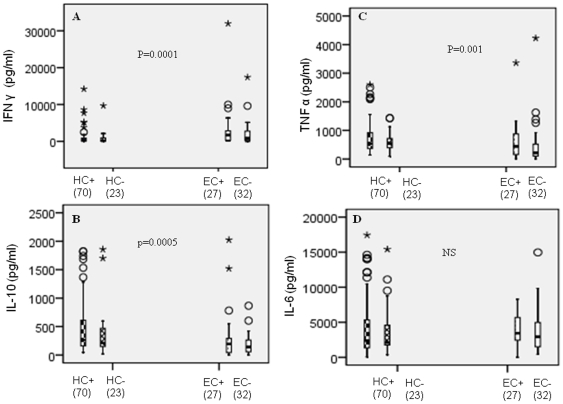
Comparison of CF induced cytokine responses in MTB exposed HC and unexposed EC.Cytokine secretion was assessed in supernatants of stimulated whole blood cultures. CF [5 µg/ml] induced IFNγ secretion was assessed at day 5 and CF induced TNF α, IL-10 and IL-6 secretion was assessed at day 2 post- stimulation. Results are expressed after deducting background secretion in the absence of stimulation. Results are given as box plots representing 25th, 50th and 75th percentiles (logn pg/ml). The number of donors in each group is given in brackets. Significant differences between the HC and EC groups for different cytokines (ANOVA; Kruskal-Wallis test) are given as p values in Figure 1.